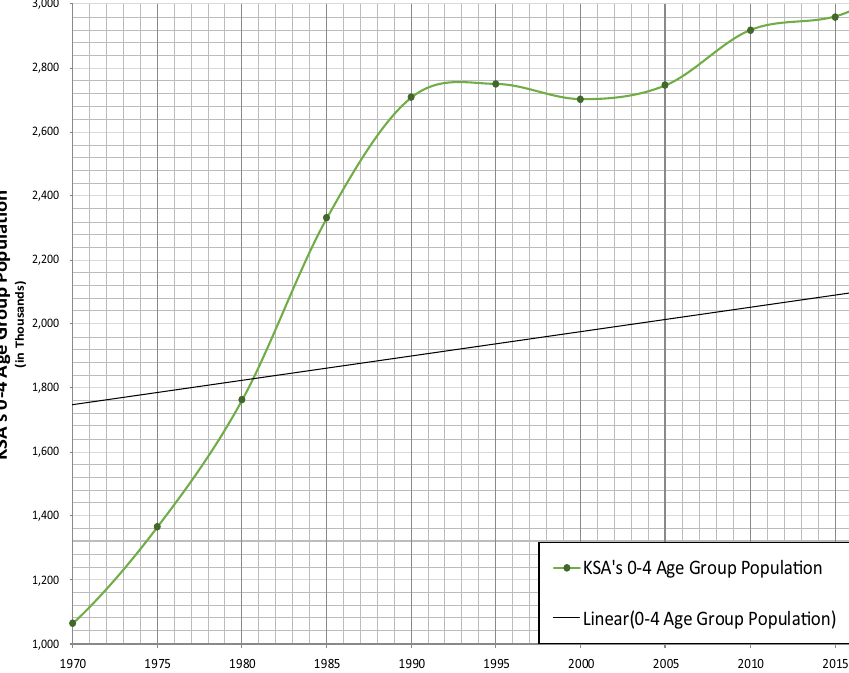
Figure 2. Kingdom of Saudi Arabia ’ s 0-4 age group population from 1950 to 2015